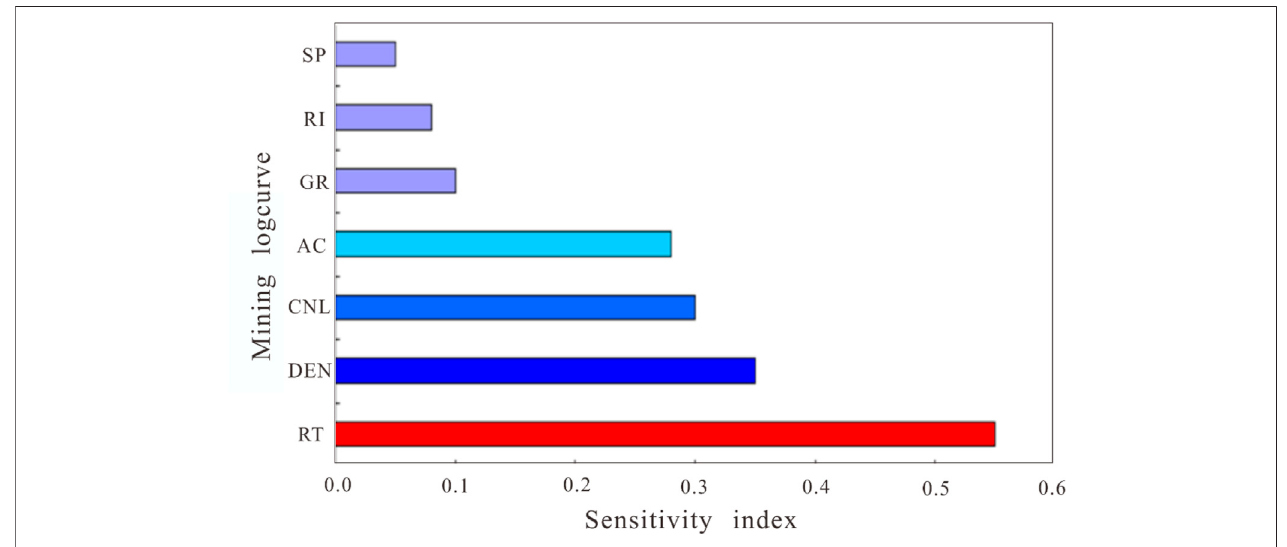
FIGURE 3 | Extraction of sensitive parameters from the data mining